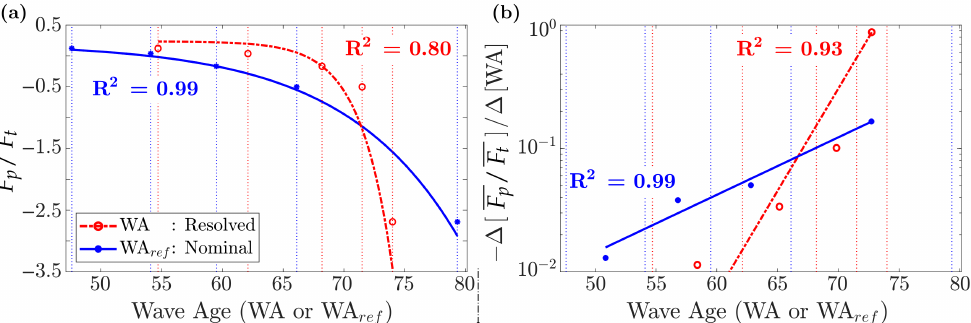
Figure 10. Wave age dependency (Resolved WA, or Nominal WA ref ) and fitting of the normalized form drag. The LES results are shown in dots and circles, and the fittings are given by full and dot-dashed lines. ( a ) Form drag and the exponential fitting in linear scale. ( b ) The negative signs of the slopes in the log scale are evaluated between the intervals of ( a ). A linear fit applies to the log of the slopes in ( b ), and integrates into the exponential in ( a ). The fitting quality was evaluated by the R 2